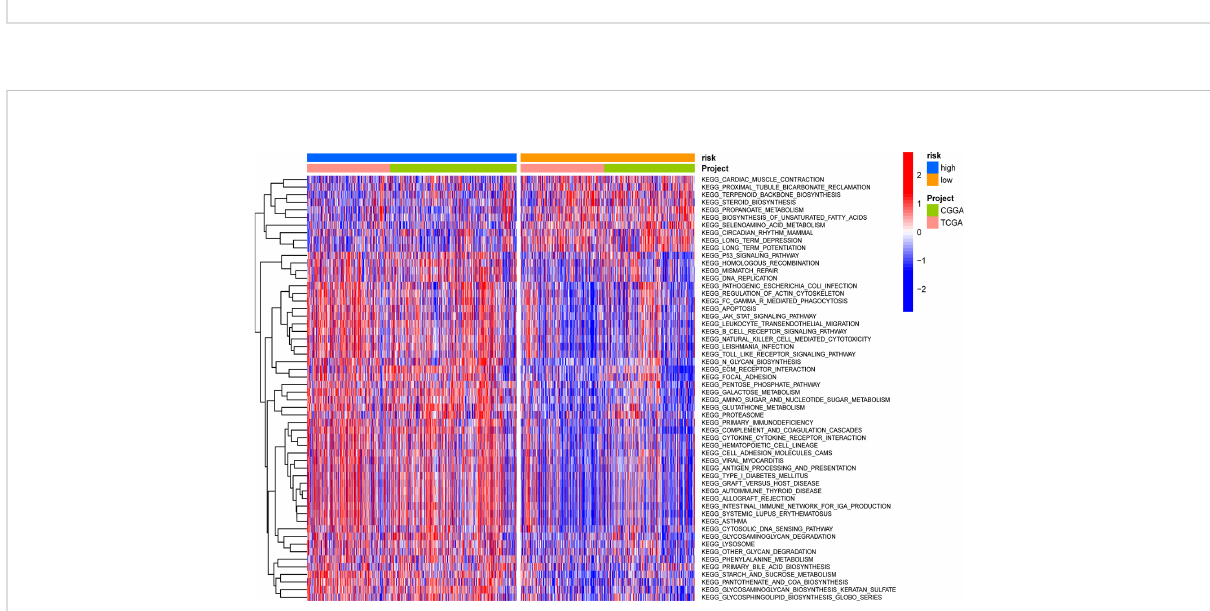
FIGURE 8 Association between risk subtypes and TMB and mutation. (A) Survival analysis of TMB and OS of the patients with LGG in TCGA. (B) K – M curves of TMB combined with risk score in TCGA-LGG. (C) Difference analysis of TMB among low- and high-risk subtypes in LGG patients. (D) Top 20 highly mutated genes in the LGG low-risk group. (E) Top 20 highly mutated genes in the LGG high-risk group. *** p < 0.0001.